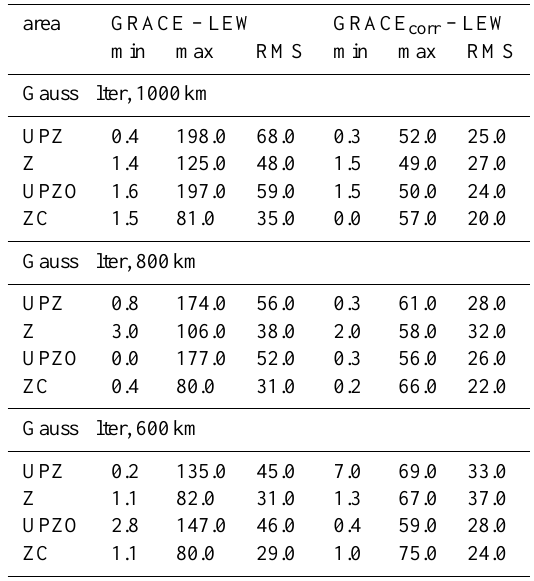
Table 3. Statistics of the differences between GRACE monthly es- timates and LEW model output before and after bias correction.